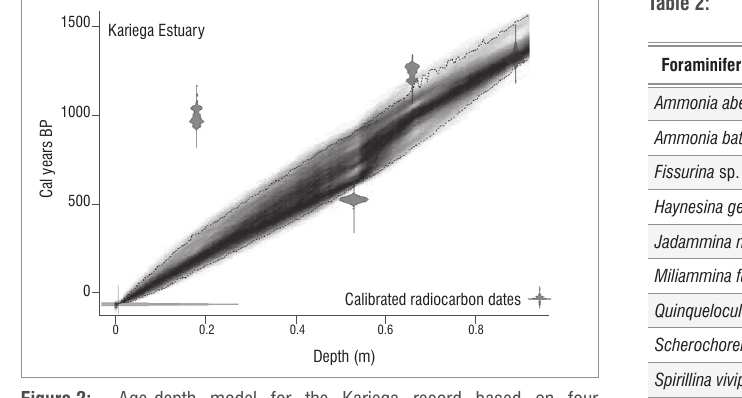
Figure 2: Age-depth model for the Kariega record based on four accelerator mass spectrometry determined ages. The surface age is assumed to represent the present day.